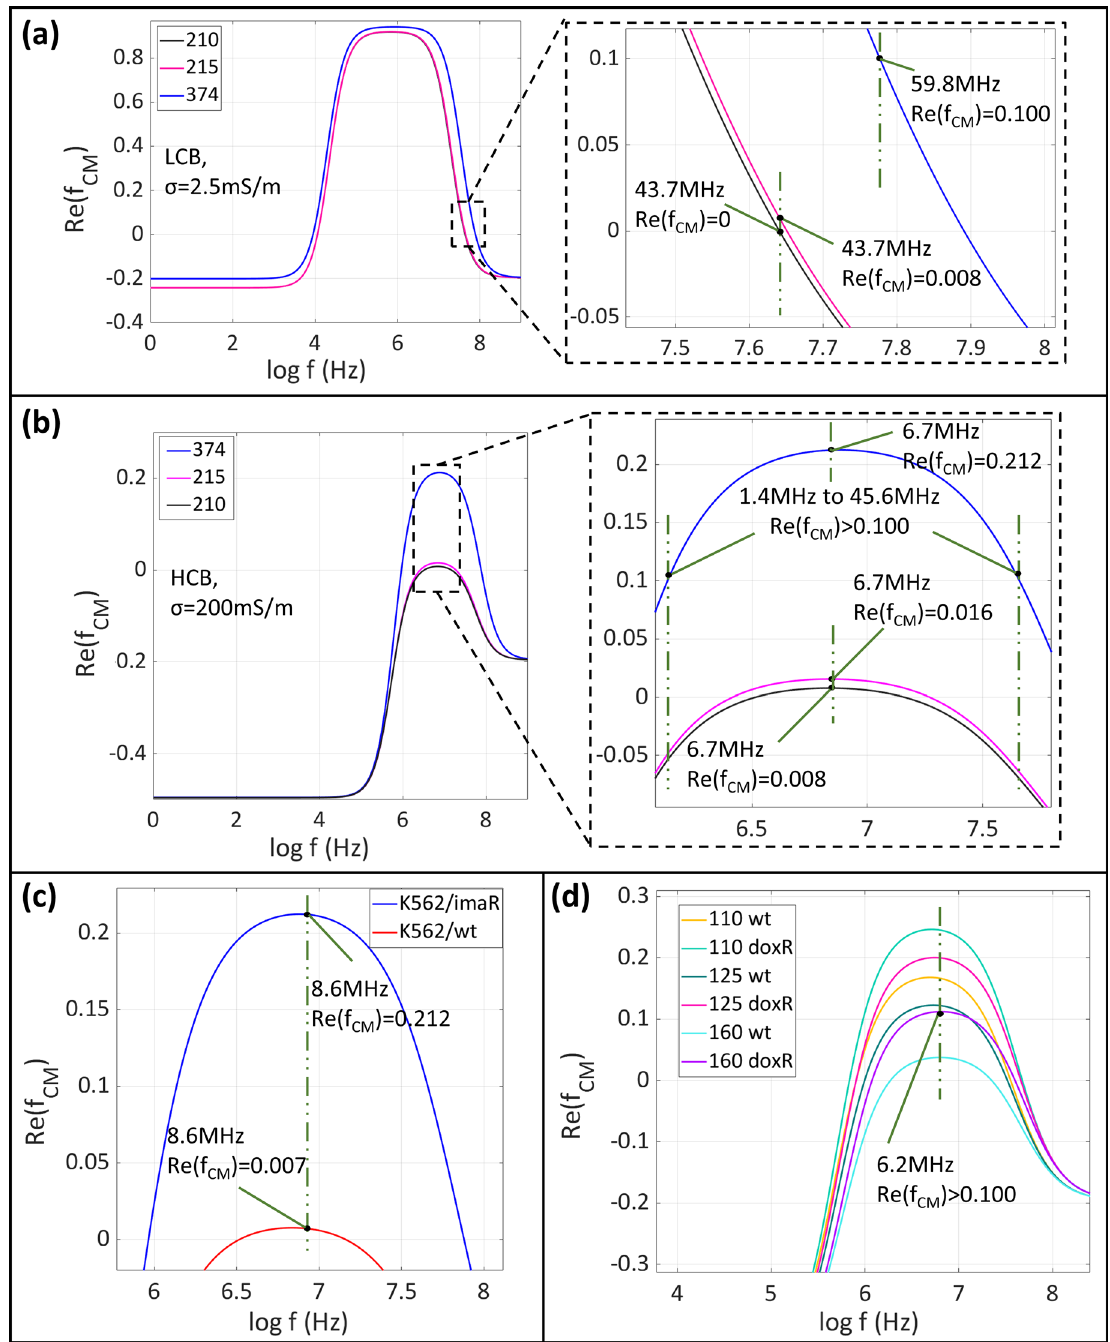
Figure 3. Single shell cell modeling to obtain Re(f CM ) characteristics of cells having cytoplasmic conductivities of 210, 215, referring K562/wt cells, and 374 mS/m, referring K562/imaR cells, in LCB (conductivity, σ = 2.5 mS/m) ( a ) and relatively HCB (σ = 200 mS/m) ( b ). ( c ) Selection of the working frequency (8.6 MHz) for K562/ wt and imaR cells in relatively HCB (σ = 200 mS/m). ( d ) Selection of the working frequency (6.2 MHz) for CCRF-CEM/wt and doxR cells in buffers (at different conductivity values: 110, 125, and 160